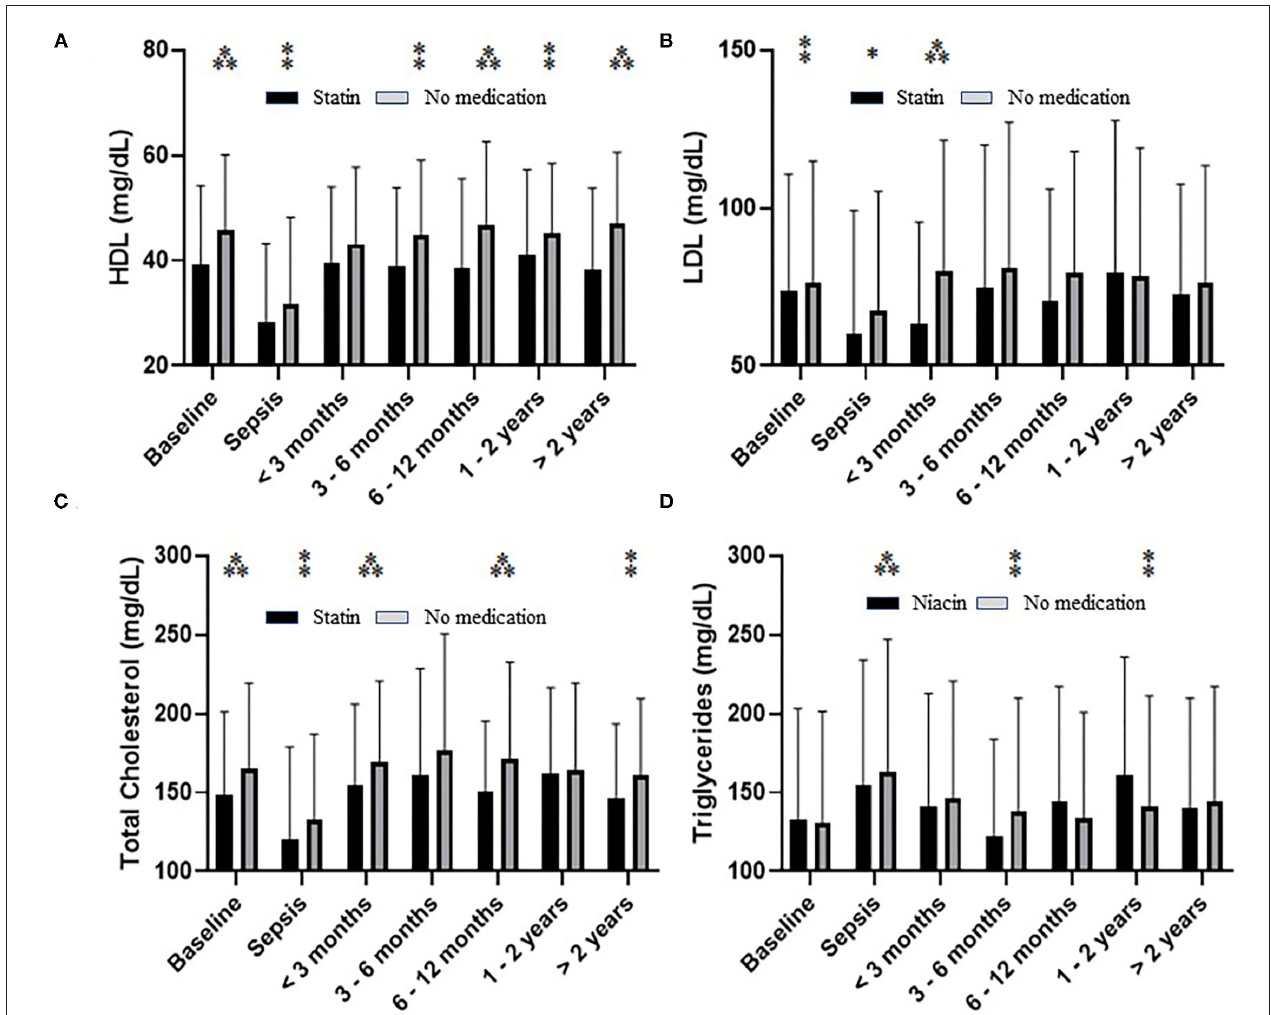
FIGURE 6 | The effect of statin on serum level of HDL-c (A) , LDL-c (B) , total cholesterol (C) , as well as niacin on triglycerides (D) during and after sepsis. Significance based on pairwise comparison is denoted by *( p < 0.05), **( p < 0.01), or ***( p < 0.001) unless noted on figure.